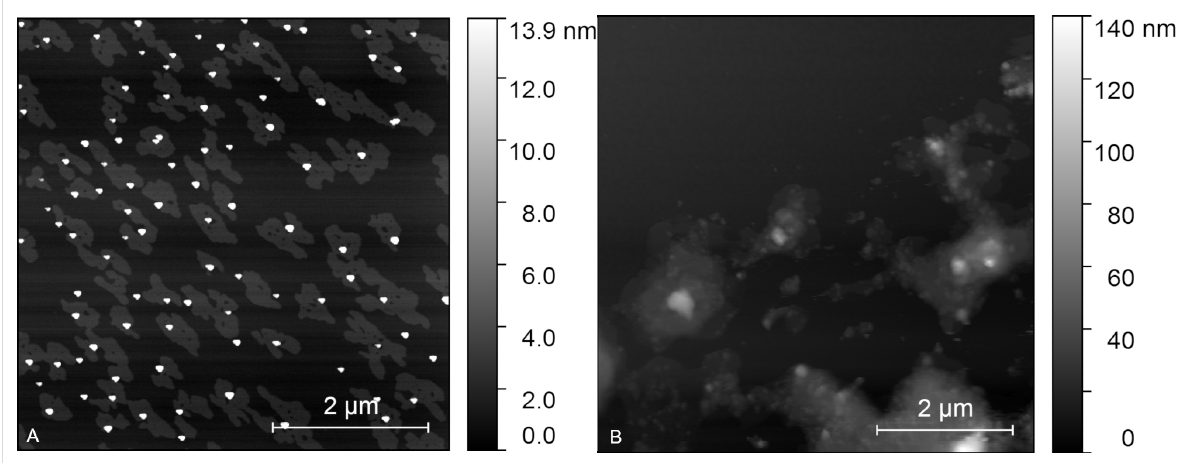
Figure 5: AFM pictures of exfoliated CaPhP: A) Particles successfully exfoliated into monolamellar sheets. B) Material destroyed by too long and too strong mixing.